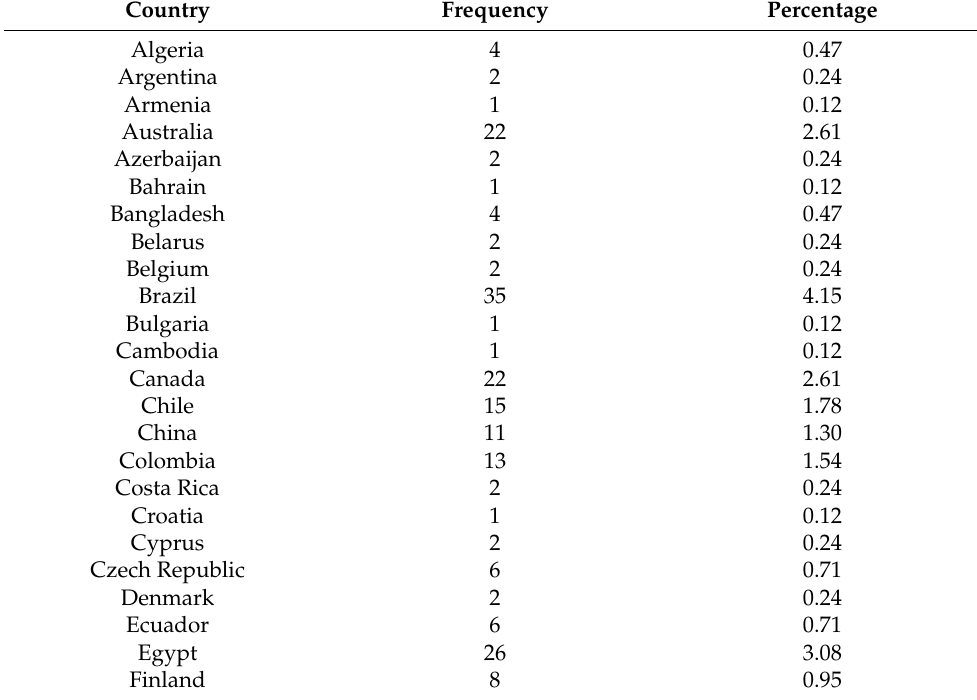
Table 1. Sample composition by